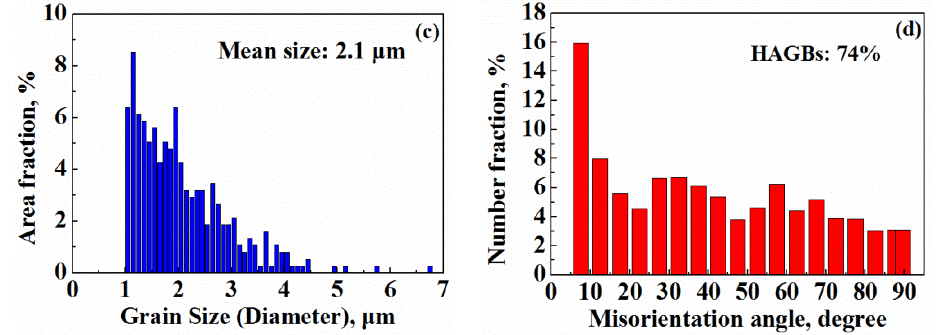
Figure 9. Microstructure and microtexture of Ti-6Al-4V specimens deformed at 900 °C/10 −2 s −1 : ( a ) the orientation map, ( b ) pole figure, ( c ) distribution of grain size of α phase, and ( d ) grain boundary misorientation of α phase.